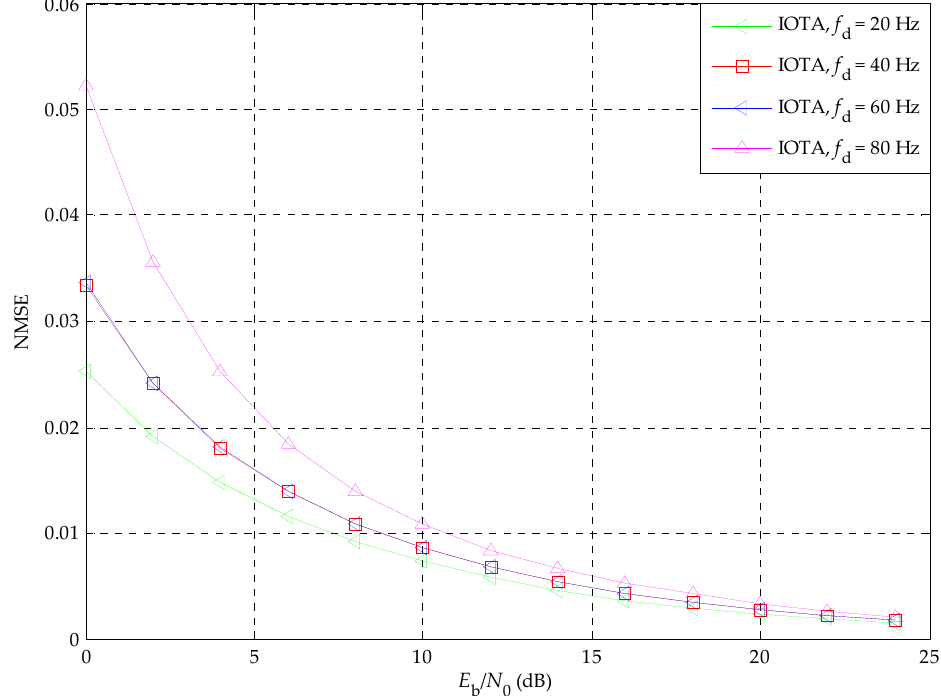
Figure 9. NMSE performance of the OFDM/OQAM system over Rayleigh fading channels with Doppler spread of 20, 40, 60, and 80 Hz.